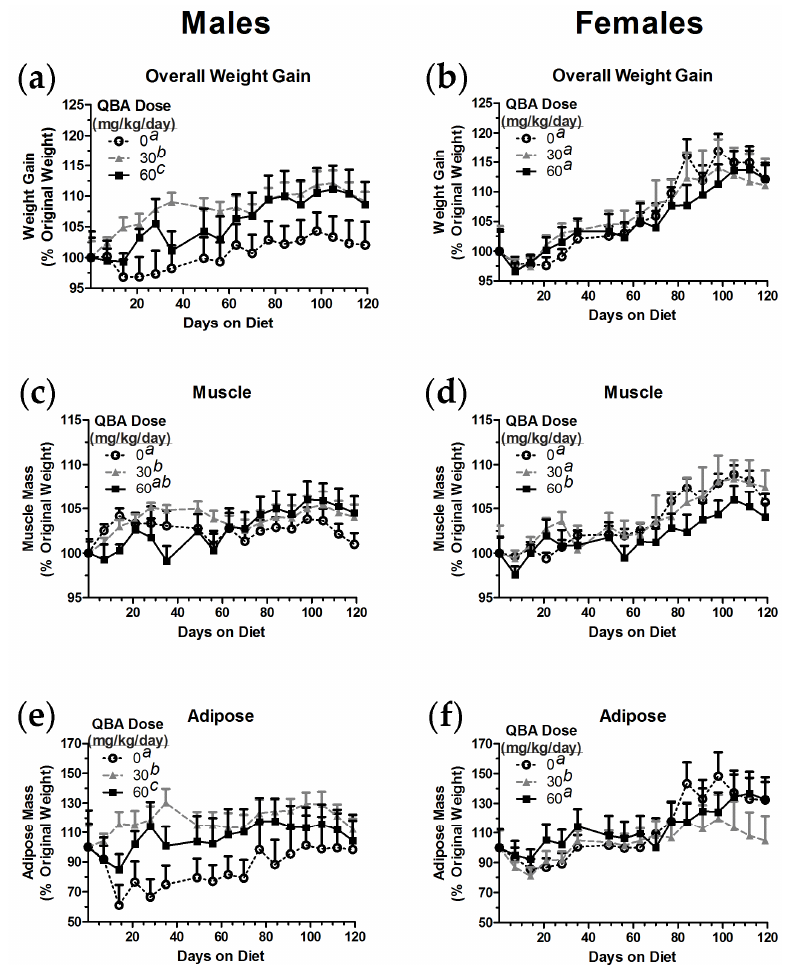
Figure 5. QBA affected the weight gain and body composition of mice in a sex-dependent manner. ( a ) The administration of QBA to male mice at doses and durations that were equivalent to those given to the aged, male rats also resulted in significantly increased weight gain in comparison to control animals. ( b ) In contrast, QBA did not affect weight gain in female mice. ( c ) Muscle mass was significantly increased in male mice by 30 mg/kg/day QBA. ( d ) Muscle mass in female mice was not affected by 30 mg/kg/day QBA, but 60 mg/kg/day QBA significantly reduced muscle mass when compared to controls. ( e ) Significant increases in adipose tissue were associated with QBA treatment in male mice. ( f ) However, female mice receiving 30 mg/kg/day QBA exhibited significant reductions in adipose tissue when compared to controls. Treatment groups not sharing common superscripts differed significantly ( p < 0.05) in 1 ‐ way RMANOVA followed by Tukey’s post hoc tests. N = 10–15 per group. Error bars represent the SEM.